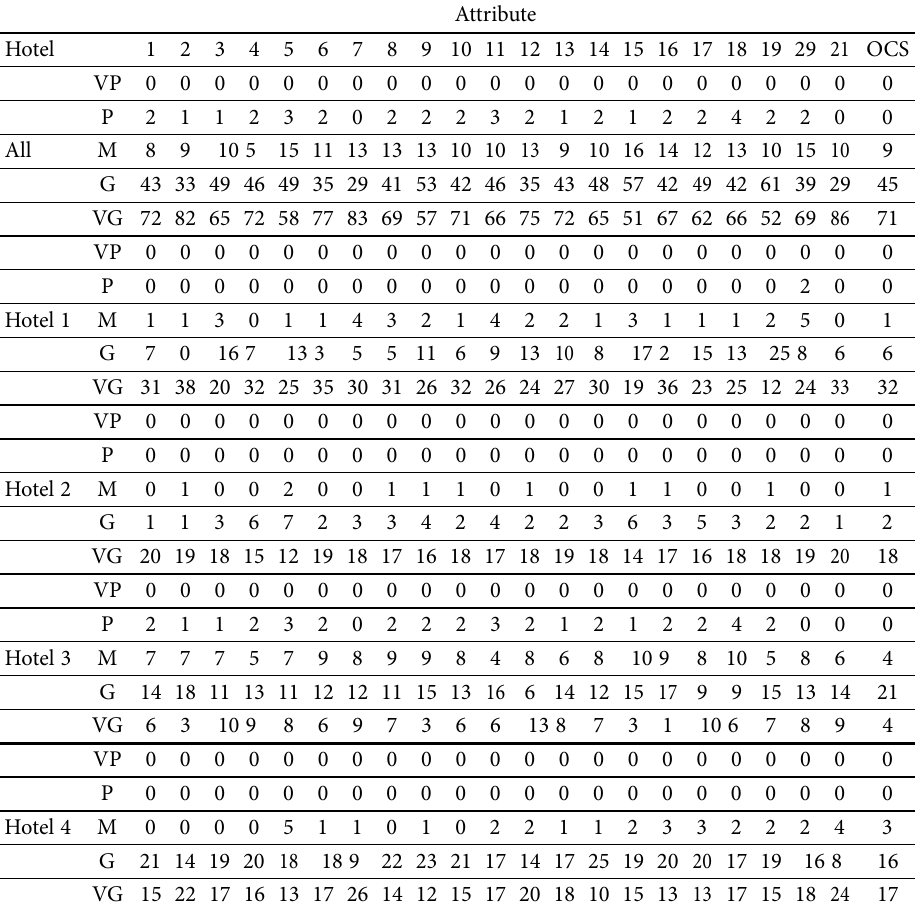
Table 2. Performance of attributes